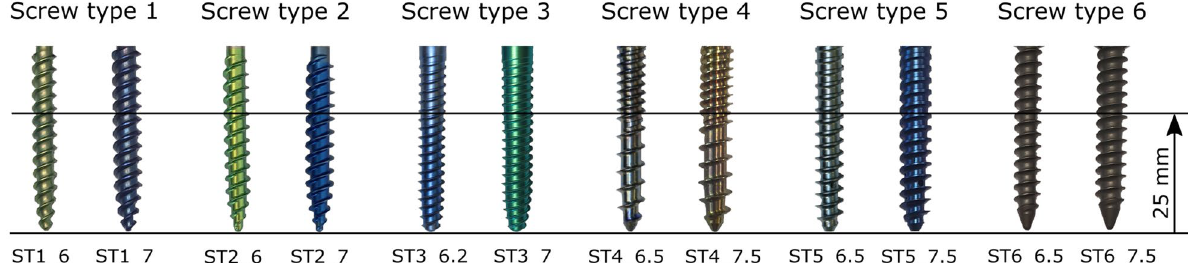
Figure 1. Six screw types examined, each in two dimensions, with the thread range considered from the tip to 25